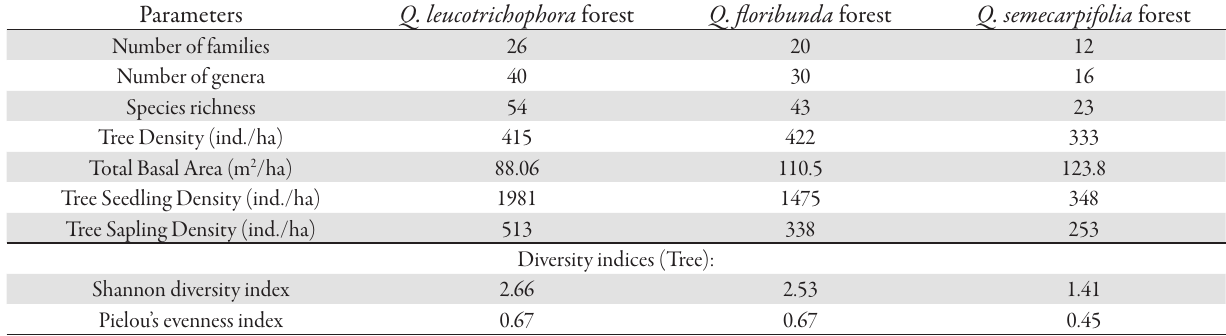
Tab. 2. Summery of plant diversity and forest characteristics of tree species across various oak forests Parameters